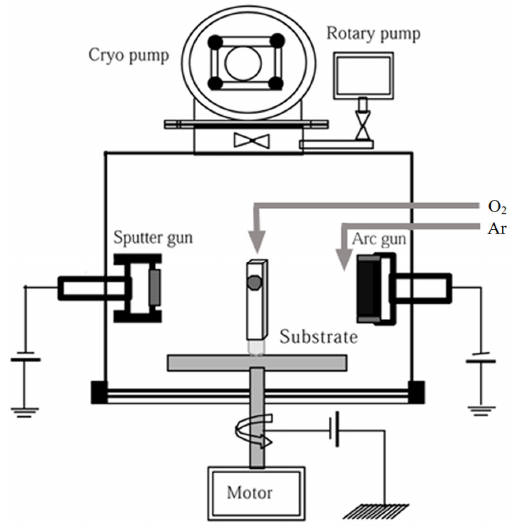
Figure 1. Sketch map of the hybrid coating system. Table 1. Detailed deposition parameters for nano ‐ crystalline Cr 2 O 3 film fabricated by arc ion plating technique.